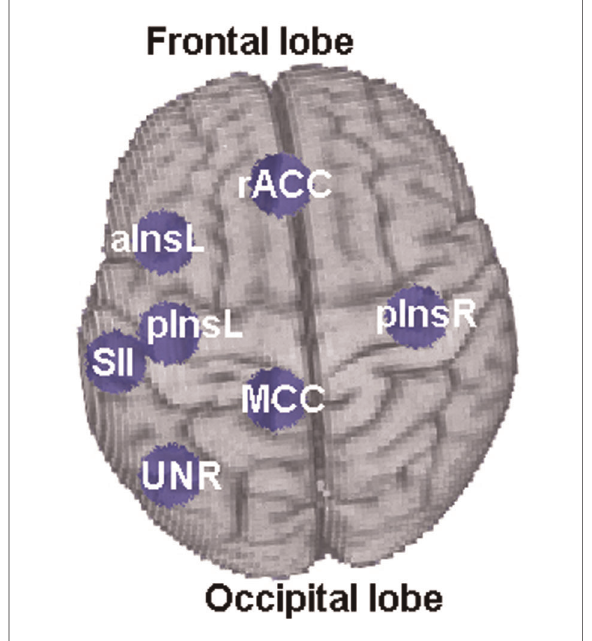
FIGURE 2 Location of the six ROIs (rACC, pInsL, pInsR, MCC, aInsL, SII) used for functional connectivity analyses. The ROI “ UNR ” corresponds to the control ROI and is shown for illustration purposes.